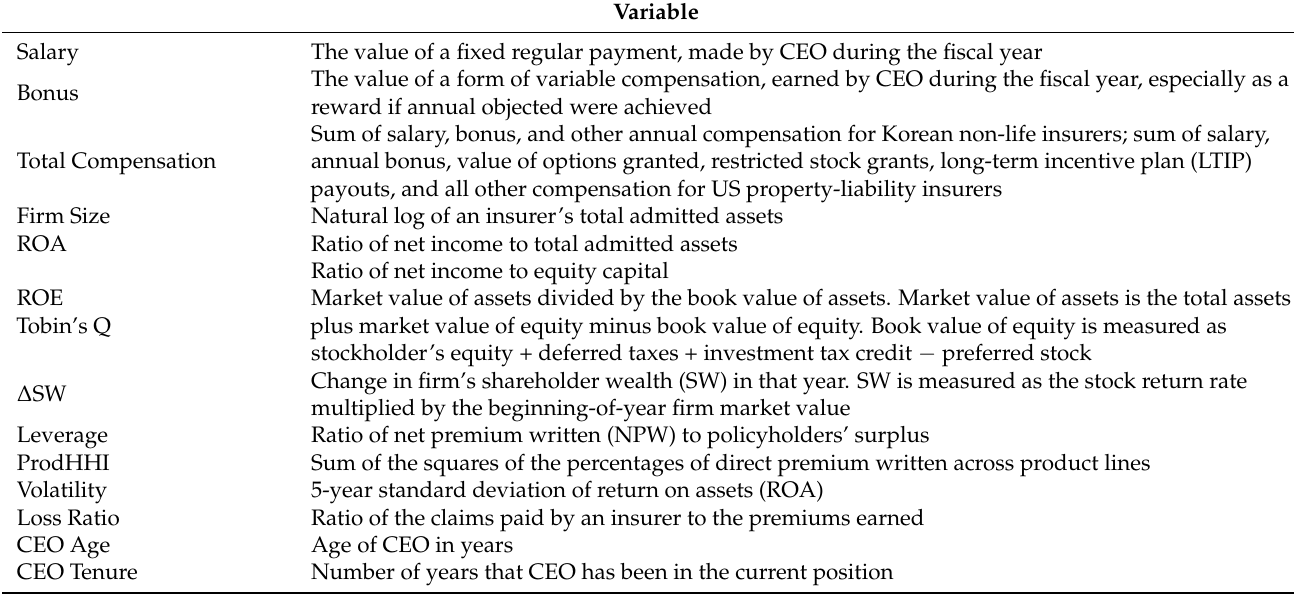
Table 1. Variables Definitions.